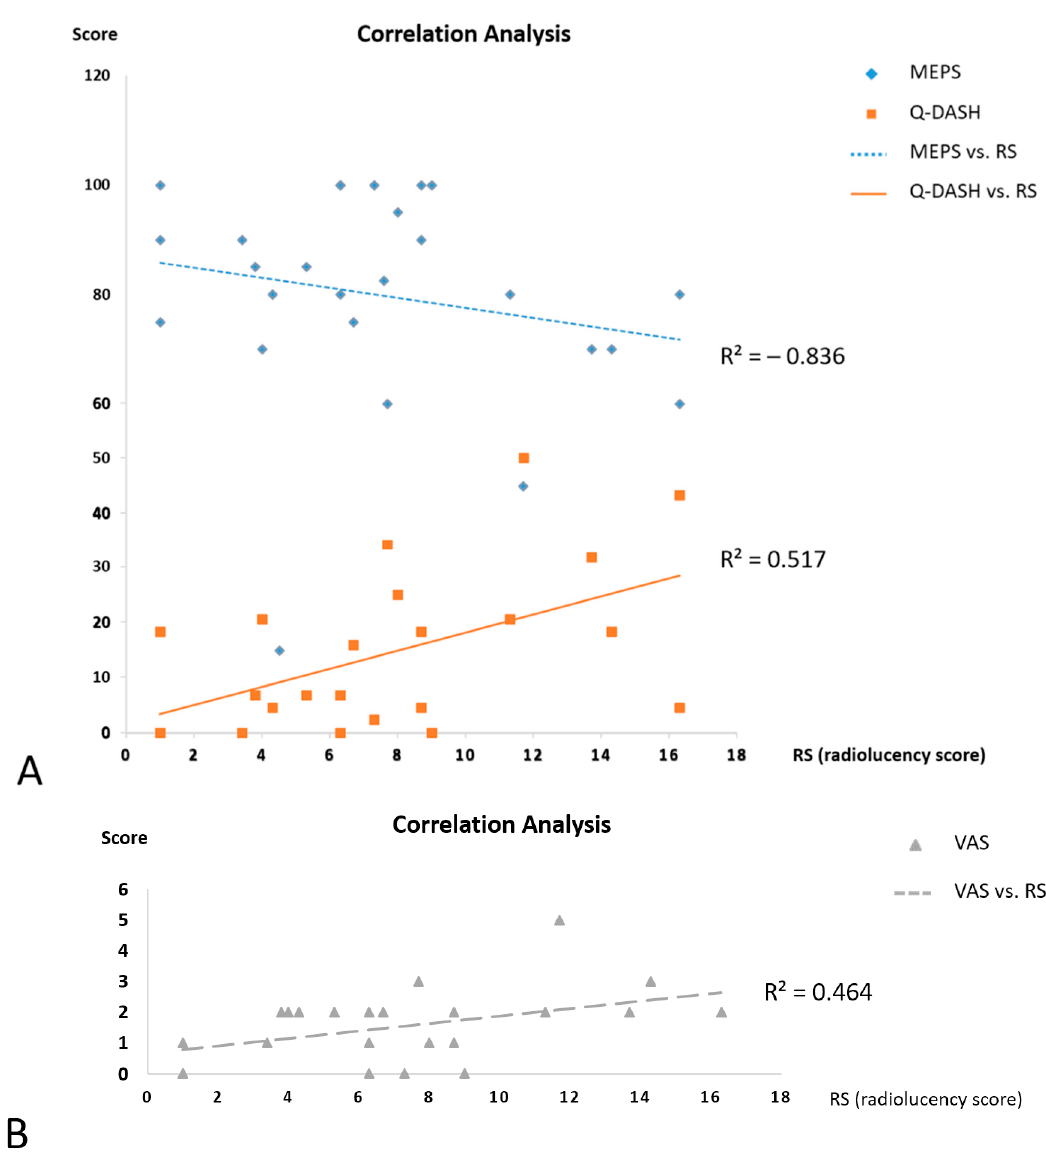
Figure 4. Correlation analysis between radiolucency score (RS) and clinical outcomes. ( A ) High correlation between MEPS, Pearson correlation coefficient R 2 = − 0.836; moderate correlation between RS and Q-DASH, R 2 = 0.517. ( B ) Moderate correlation between RS and VAS scores, R 2 = 0.464. MEPS: Mayo Elbow Performance Score; Q-DASH: QuickDASH (shortened Disabilities of the Arm, Shoulder, and Hand); VAS: visual analog scale.